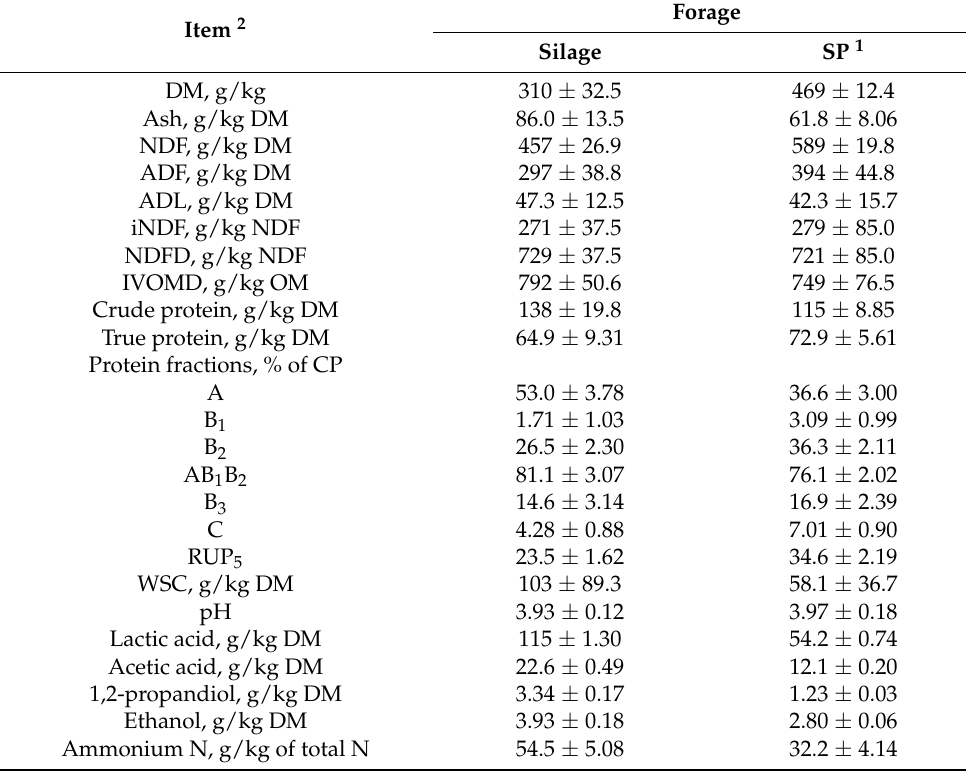
Table 1. Chemical composition (mean ± SD) of the experimental forages ( n =